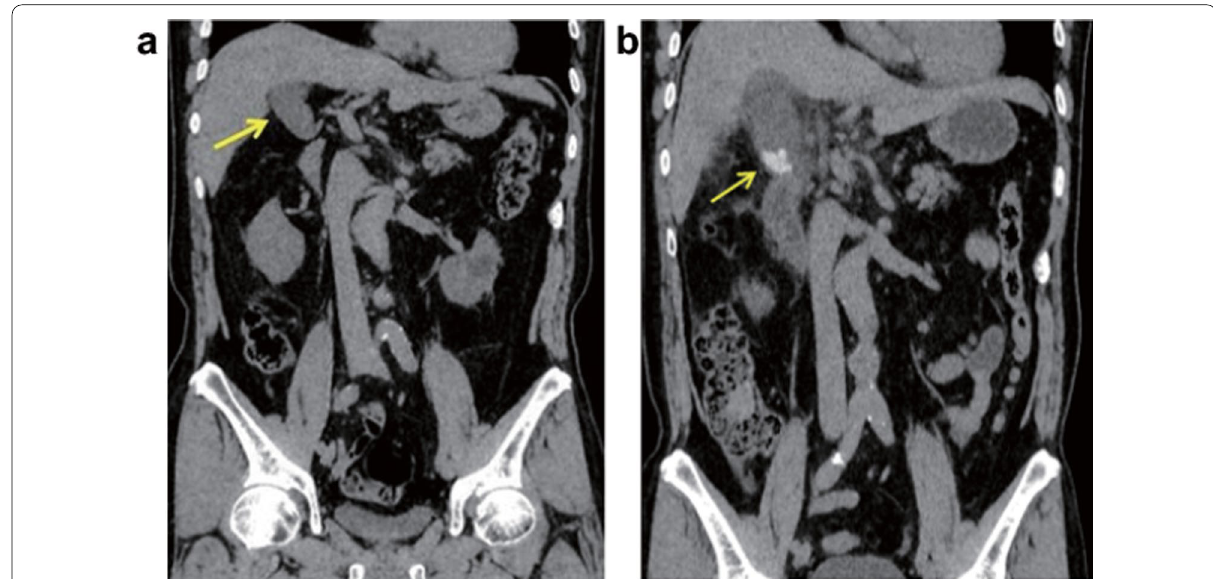
Fig. 1 Computed tomography study. Coronal CT section before ( a ) and after ( b ) the administration of ceftriaxone. Gallbladder stone was not detected before ceftriaxone ( a ). However, an inflamed gallbladder (arrow) with stones can be visualized after ceftriaxone administration ( b